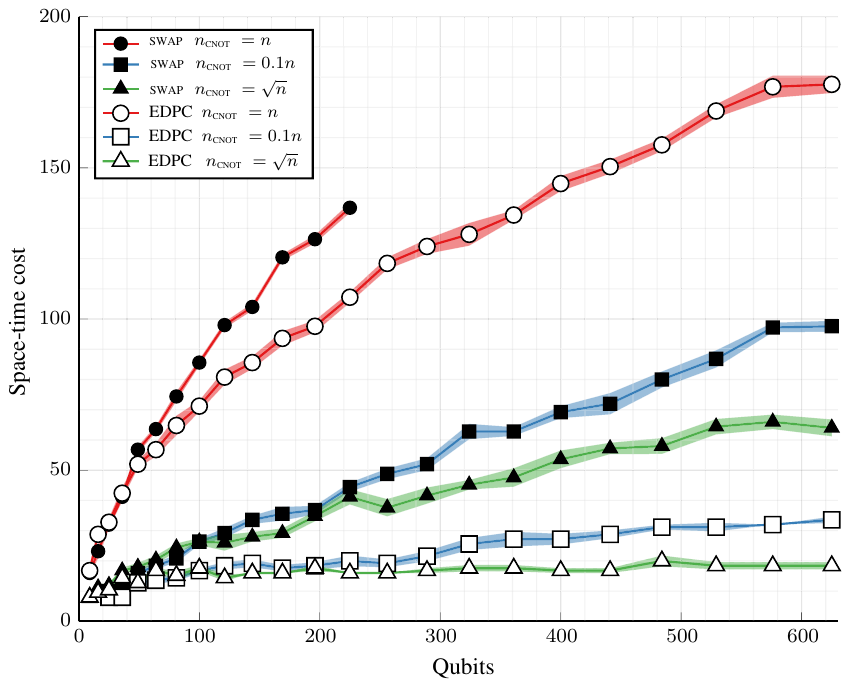
FIG. 12. Space-time cost of a ran- domly sampled set of disjoint CNOT gates with standard error of the mean (shaded region) compiled to the surface code using EDPC and SWAP compilation. We generate ten random circuits for each number of qubits ( n ) consisting of a set of disjoint CNOT gates of varying density; the number of randomly selected qubits involved in a CNOT gate is given by . At all densities we see improved n CNOT performance and scaling using EDPC.